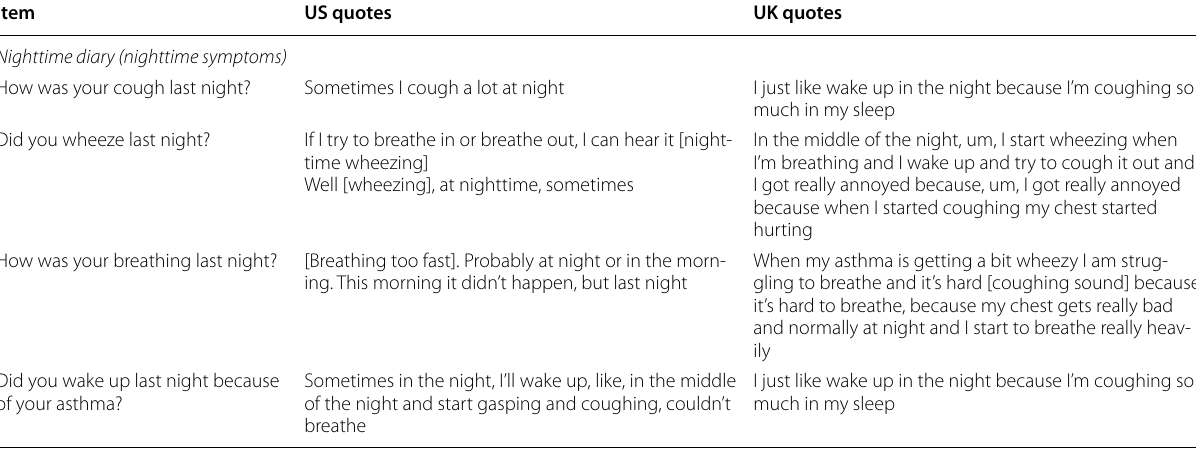
Table 4 Draft ePASD nighttime symptom and proximal activity items with selected quotes from child concept elicitation interview participants